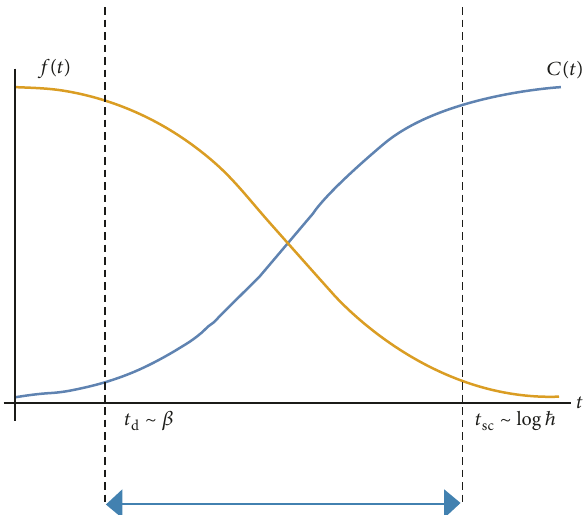
Figure 7: A schematic representation of the chaos diagnostic function(s). Here, qualitatively, 𝑓(𝑡) = 1 − 𝐶(𝑡) , while both 𝑓(𝑡) and 𝐶(𝑡) individually carry the information of an exponential decay (for 𝑓(𝑡) ) or growth (for 𝐶(𝑡) ) of the corresponding correlator. The exponentialbehaviouroccursinaregimebetweena O (1) time-scale, such as the dissipation time 𝑡 푑 , and a parametrically large time-scale, suchas thescramblingtime 𝑡 .Thishierarchy of 𝑡 푑 and 𝑡 isensured sc sc in the ℏ 󳨀→ 0